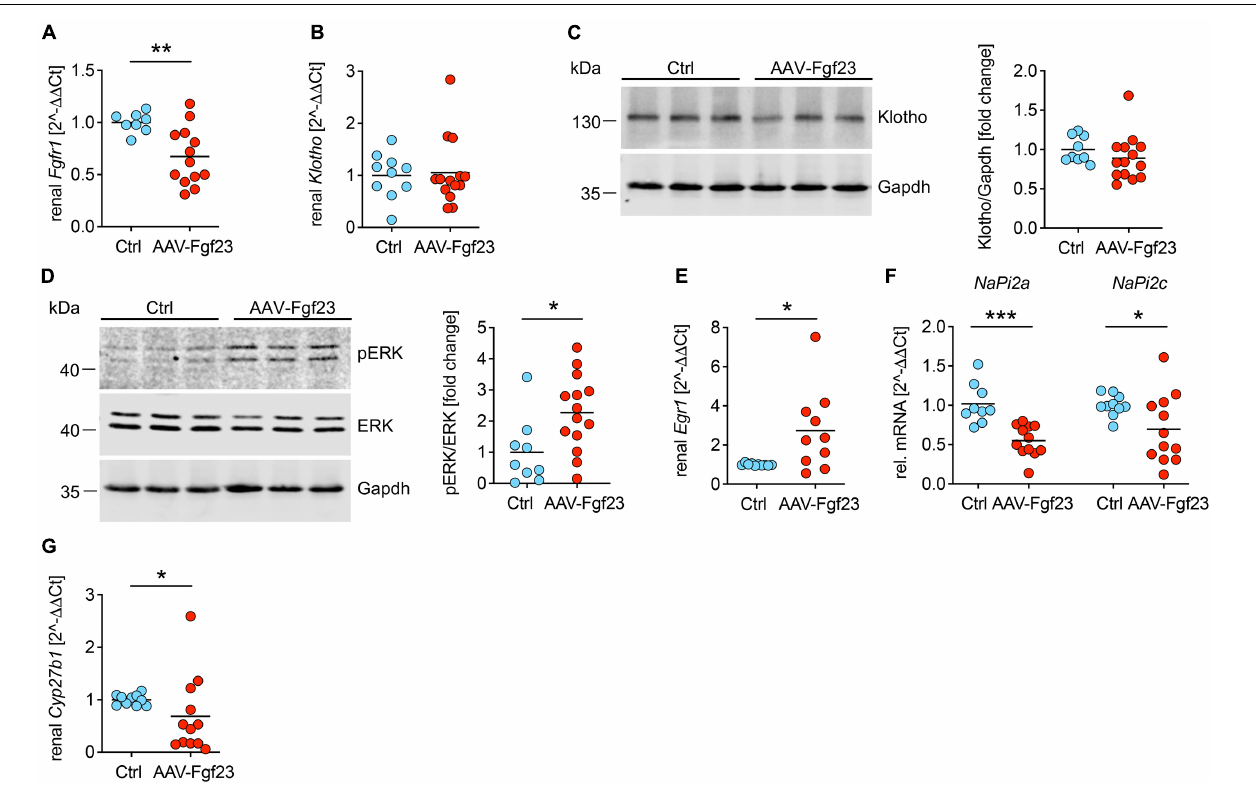
FIGURE 6 | Enhanced secretion of cardiac iFgf23 activates FGFR1/klotho/ERK signaling in the kidney. (A) Analyzed by quantitative real-time PCR, renal expression of Fgfr1 is decreased in AAV-Fgf23 mice compared to Ctrl. (B) Renal Klotho mRNA levels are equal in both groups. (C) Representative immunoblots followed by quantification verify normal klotho protein levels in kidney tissue of AAV-Fgf23 mice compared to Ctrl. Gapdh serves as the loading control. (D) Representative immunoblots in kidney tissue followed by quantification show increased phosphorylation of ERK1/2 in AAV-Fgf23 mice compared to Ctrl with no changes of total ERK1/2 protein. Gapdh serves as the loading control. (E) Renal mRNA expression of Egr1 increases in AAV-Fgf23 mice compared to Ctrl, confirming AAV-Fgf23 mediated activation of ERK signaling pathway. (F) Renal mRNA expression of NaPi2a and NaPi2c decreases in AAV-Fgf23 mice compared to Ctrl. (G) mRNA expression of Cyp27b1 is downregulated in AAV-Fgf23 mice compared to Ctrl. Data are given as scatter dot plots with means; * p < 0.05, ** p < 0.01, and *** p < 0.001 analyzed using unpaired t -test or Mann–Whitney test according to D’Agostino and Pearson’s normality test; n = 8–14 mice per